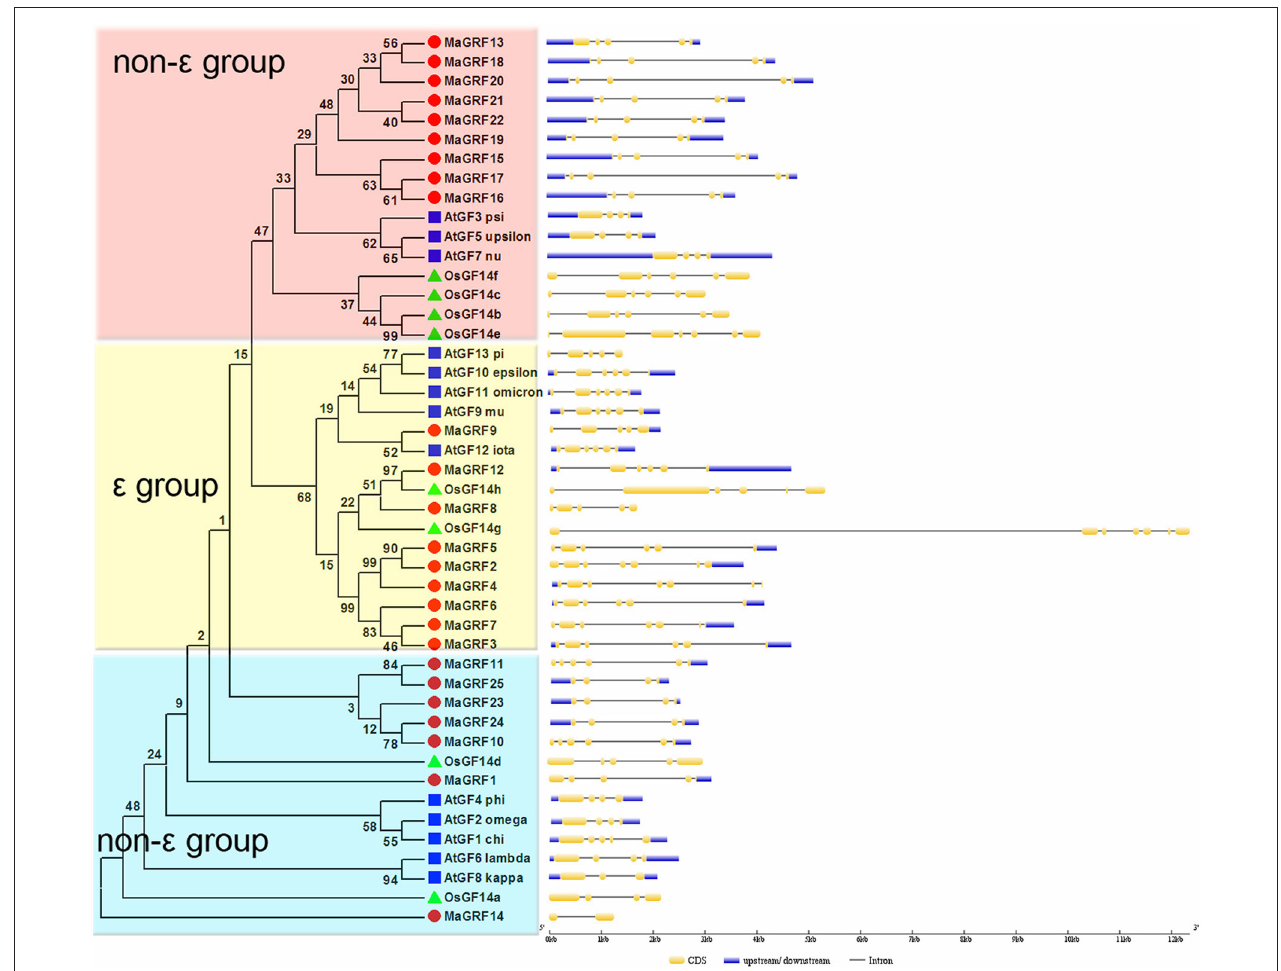
FIGURE 3 | The Phylogenetic relationship and exon-intron structure analyses of 14-3-3s from banana, Arabidopsis, and rice. The neighbor-joining tree was created using ClustalX 2.0 and MEGA5.0 with amino acid sequences of 14-3-3s from banana, Arabidopsis and rice. Two groups are indicated with different color backgrounds. Exon-intron structure analyses were conducted using the GSDS database. Lengths of exons and introns of each 14-3-3 gene were exhibited